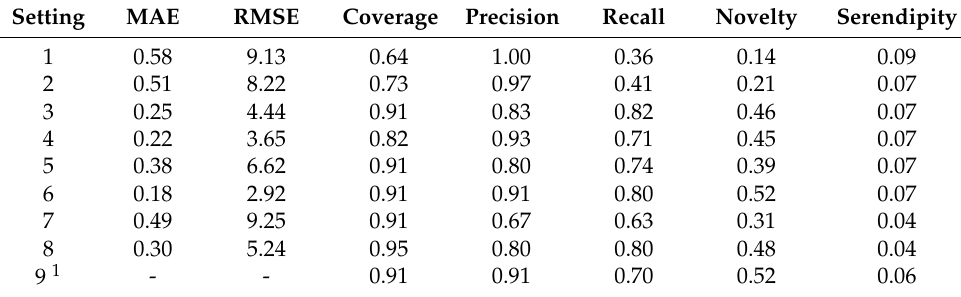
Table 3. RS performance measurements with training data.